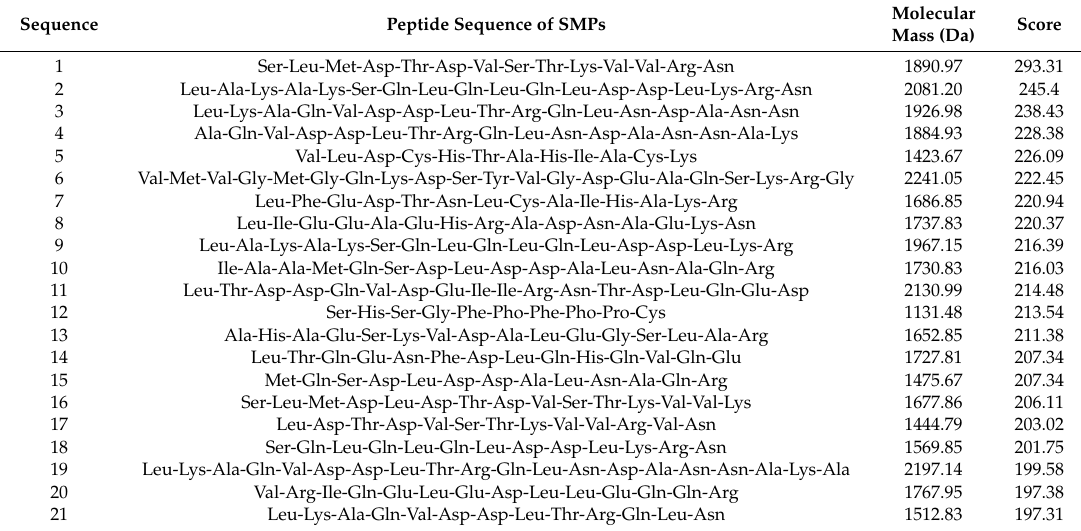
Table 2. Main peptide sequences analysis from of SMPs.